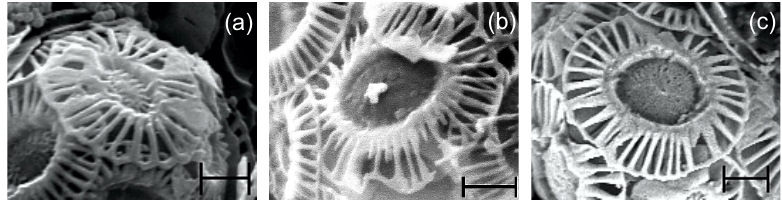
Figure 3. Examples of malformed coccoliths found in E. huxleyi RCC1710 (a) , RCC1252 (b) , and IAN01 (c) . Scale bar equal to 1µm.